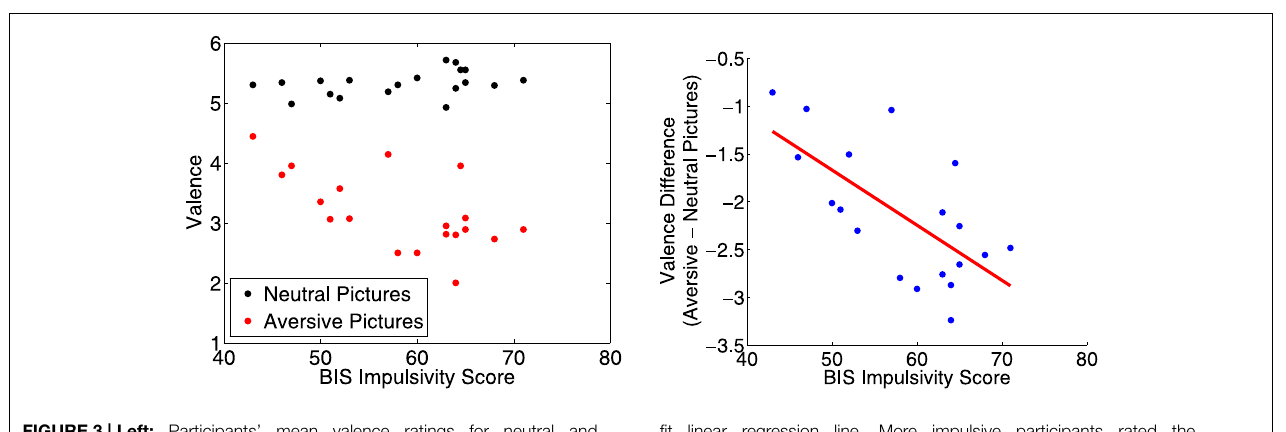
fit linear regression line. More impulsive participants rated the aversive pictures as more unpleasant (lower valence score). The correlation was significant ( r = − 0 . 67 , p = 0 . 002 , t = − 3 . 76 , df = 17